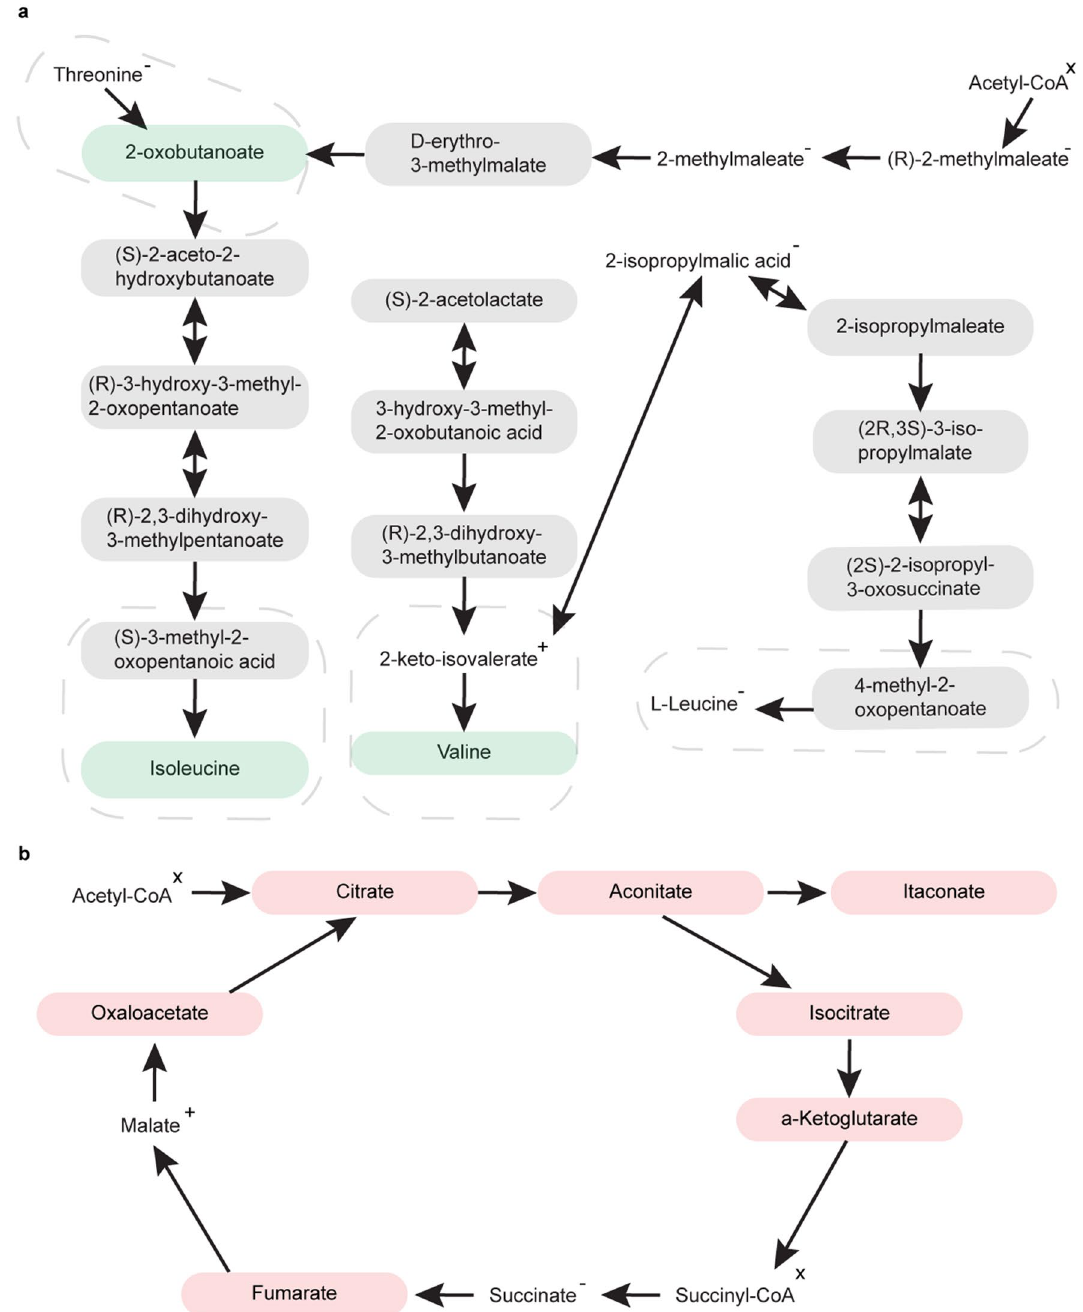
Figure 3. Pathway analysis of metabolites with significant differentially quantified concentrations using MetaboAnalyst 81–83 . Red indicates upregulation in DEL and green denotes downregulation. Grey represents metabolites not included in our targeted metabolomics protocol. Superscripts signify direction of change for the metabolites that did not exhibit significant differential concentrations. The +, −, and × superscripts indicate upregulated (in DEL), downregulated (in DEL), and signal too low or not present, respectively. ( a ) At PREOP, the valine, leucine, and isoleucine biosynthesis pathway was the only one with metabolites with significantly differentially quantified concentrations (FDR < 0.04). Dashed boxes represent the reactions that are specific to human. ( b ) At POD2, the citrate cycle pathway was the most significantly